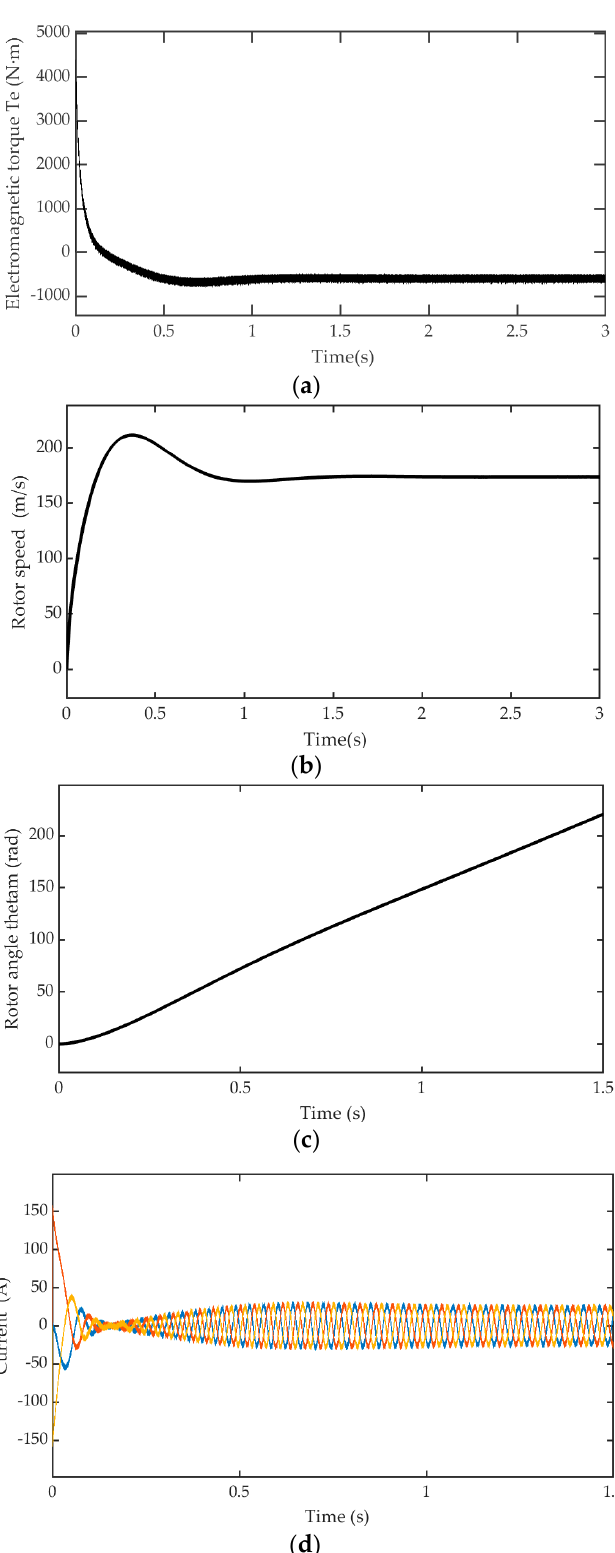
Figure 18. System block diagram.